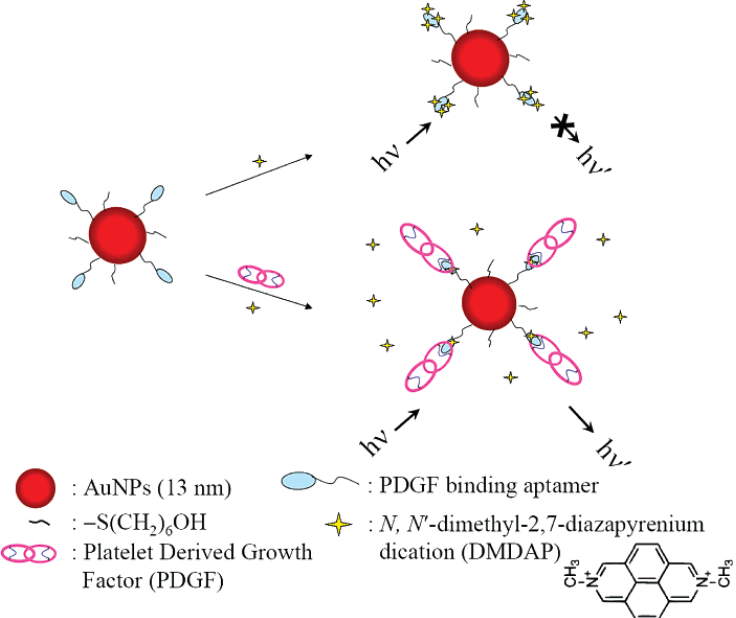
Figure 9. Schematic representations of PDGF nanosensors that operate based on modulation of the fluorescence resonance energy transfer between DMDAP and Apt-Au NPs. Reprinted with permission from Reference